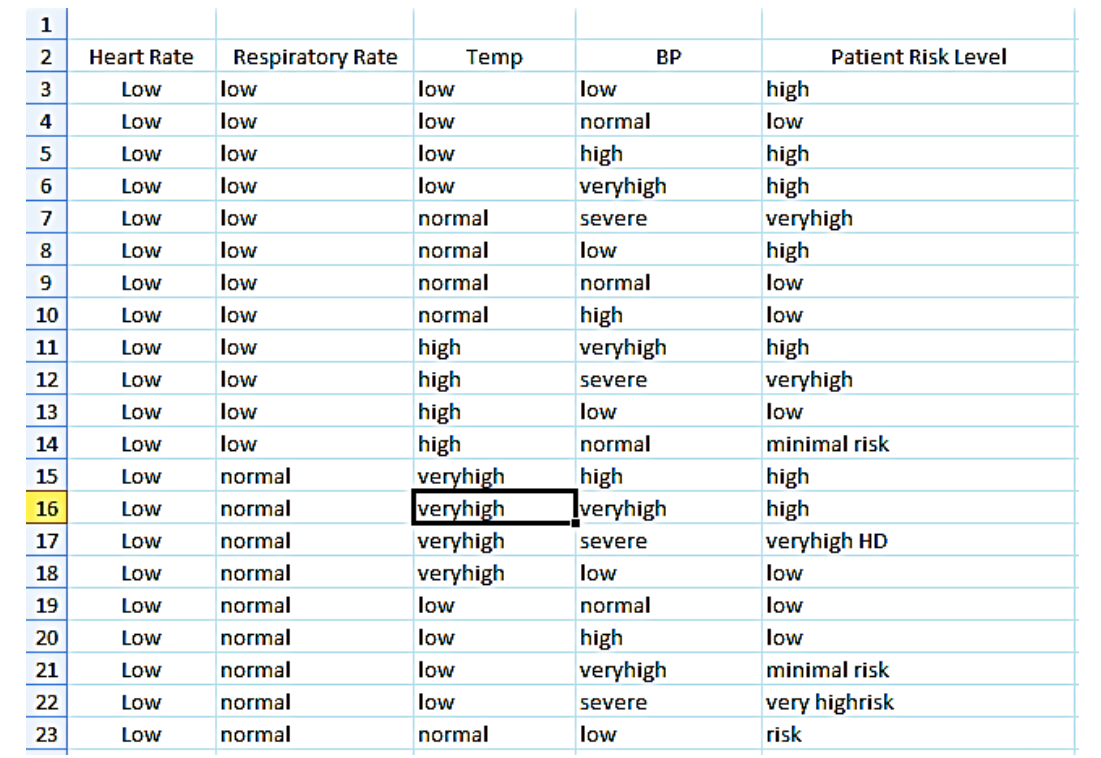
Fig. 5. Rule base for cardiac patient shock level